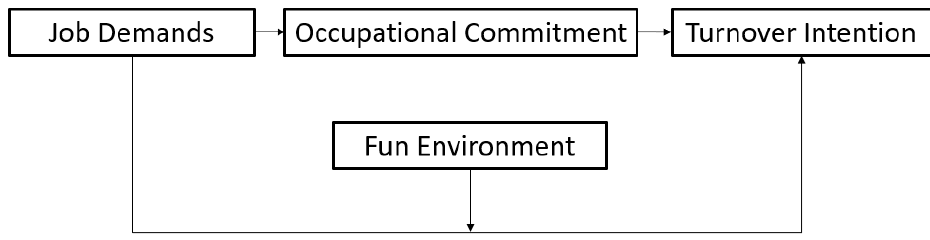
Figure 2. Final Model.